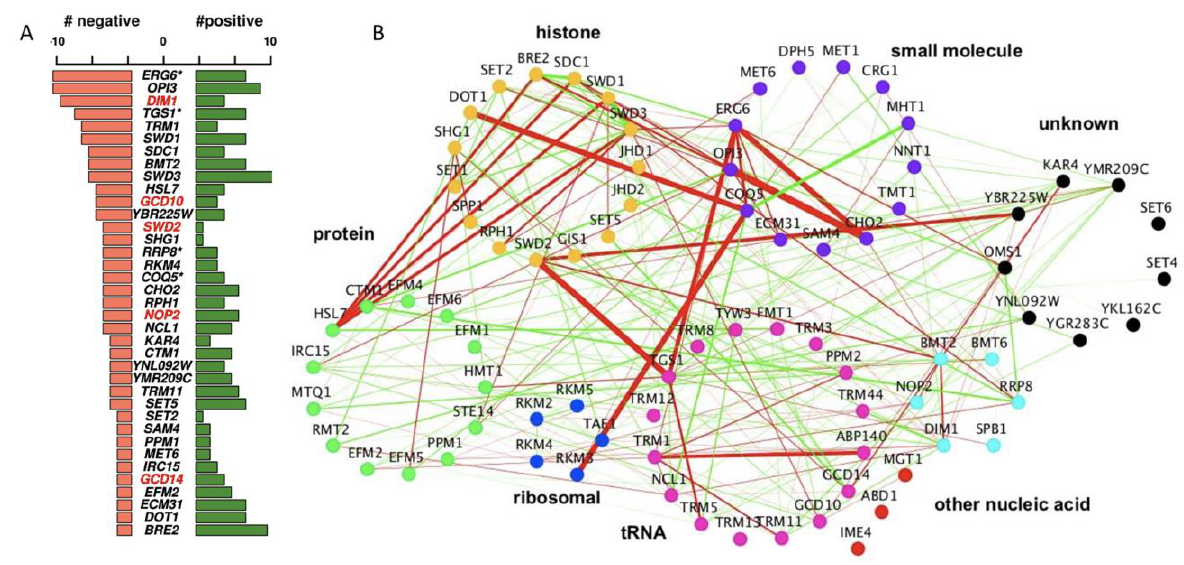
FIGURE 2: Genetic architecture of the yeast methyltransferome. (A) Frequency of high-confidence positive and negative genetic interac- tions (|score| >2.5) across the methyltransferome network. Essential genes are labeled in red; * indicates slow growers. (B) Genetic inter- action network of the yeast methyltransferome under the standard growth condition (30°C). Each MT gene is represented as a node in the network and significant genetic interactions by edges. Nodes are colored according to the substrate type. Edge width represents the strength of the genetic, interaction score and edge color the interaction type (red negative, green